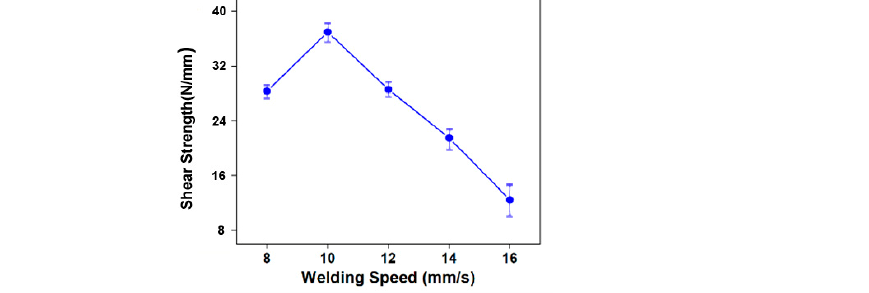
Figure 7. Details of fracture surface at different welding speed: ( a ) 16 mm/s, ( b ) 14 mm/s, ( c ) 12 mm/s, ( d ) 10 mm/s, ( e ) 8 mm/s, and ( f ) 6 mm/s.